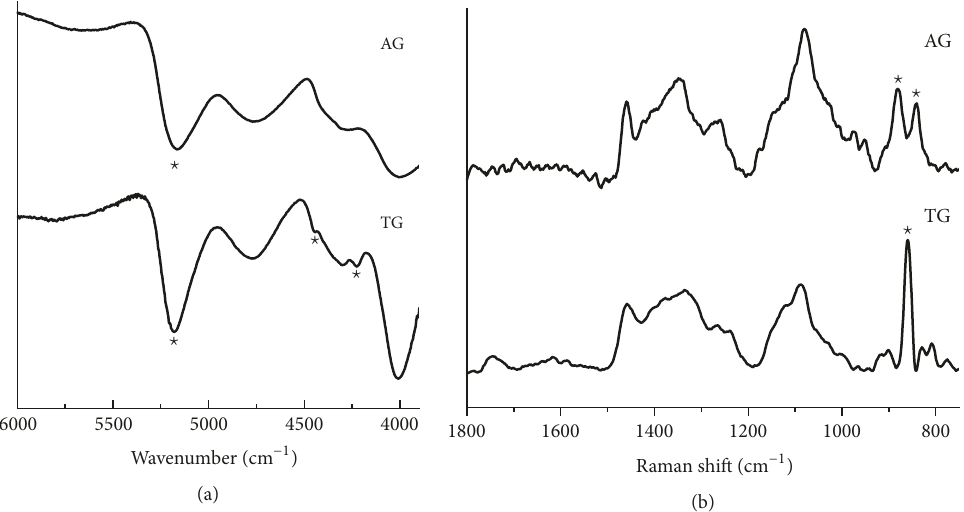
Figure 4: FT-NIR (a) and Raman (b) spectra of tragacanth gum-TG and Arabic gum-AG. Raman spectra are presented after background subtraction. Star symbols point to some specific spectral features discussed in the text. The assignments of the FT-NIR and Raman spectra are reported in Tables S7 and